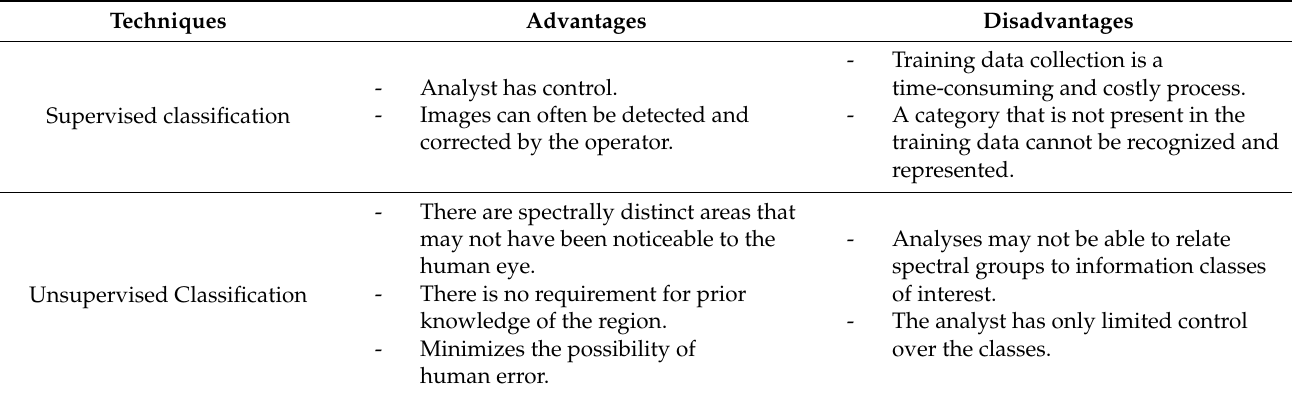
Table 1 provids an overview of some classification and change detection techniques and their advantages and disadvantages. Table 1. Classification and change detection techniques for detecting vegetation cover